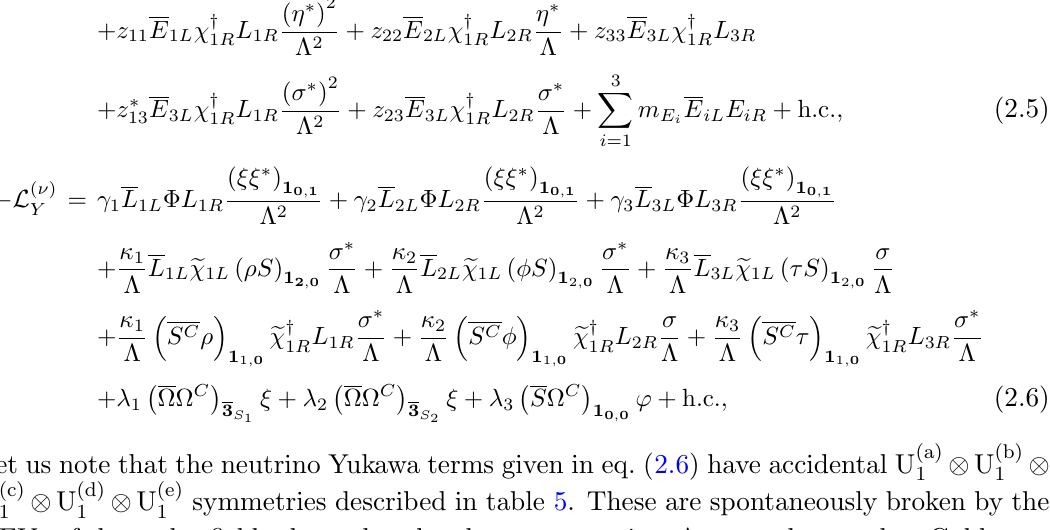
U (b) U (c) U (d) U (e) 1 (cid:10) 1 (cid:10) 1 (cid:10) 1 (cid:10) 1